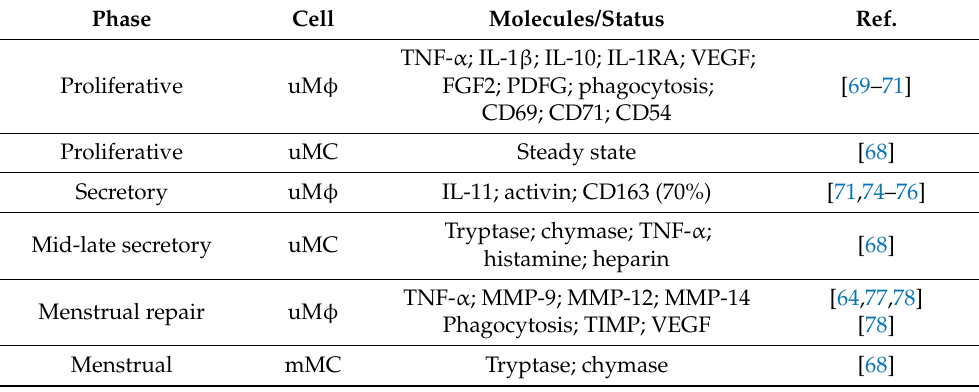
Table 2. Cytokines and mediators produced by uterine mast cells and macrophages during the different phases of the menstrual cycle under physiological conditions. Abbreviations: uM φ s